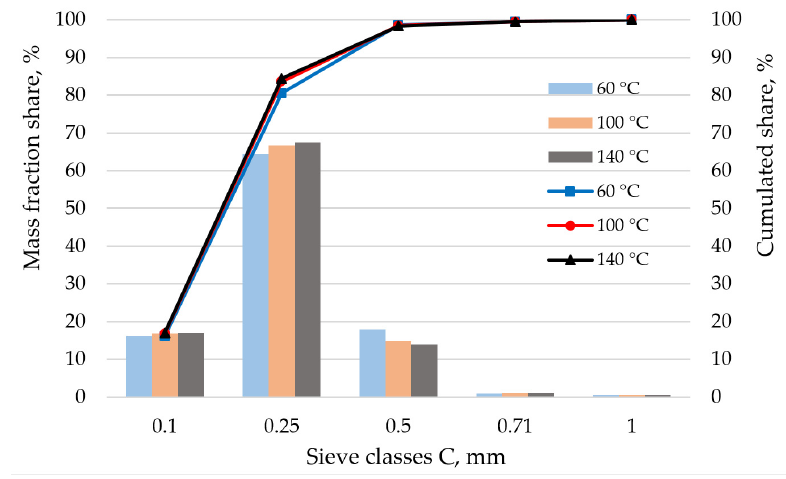
Figure 1. Analysis of samples’ particle size distribution.